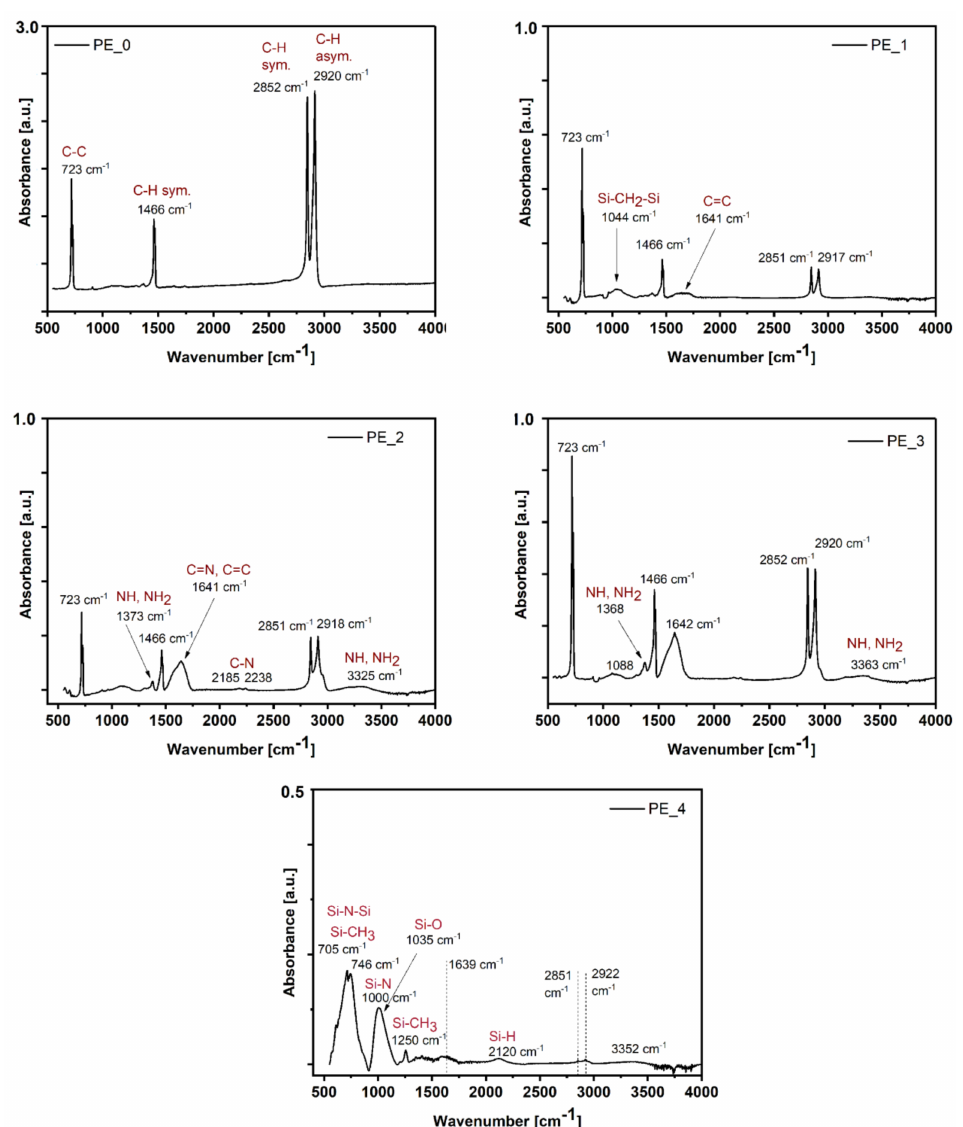
Figure 3. FTIR-ATR spectra of unmodified (PE_0) and surface-modified low-density polyethylene: (PE_1) DLC deposition; (PE_2) N-DLC deposition; (PE_3) N-DLC and DLC deposition; (PE_4) N-DLC and Si-DLC